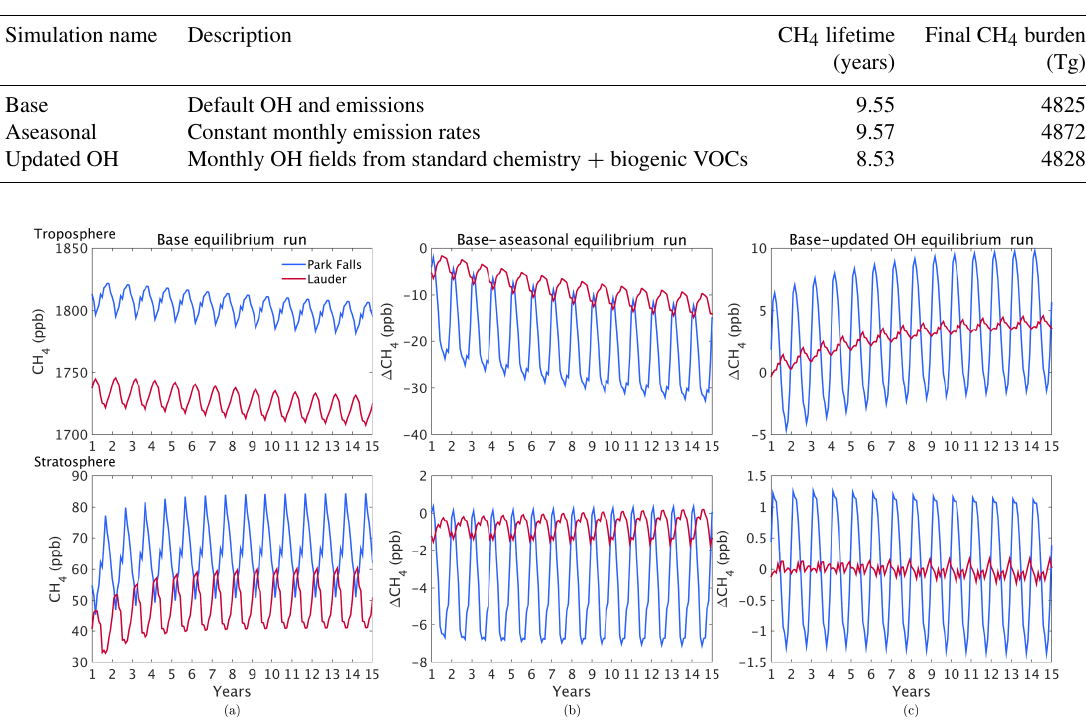
Table 2. Sensitivity experiments.